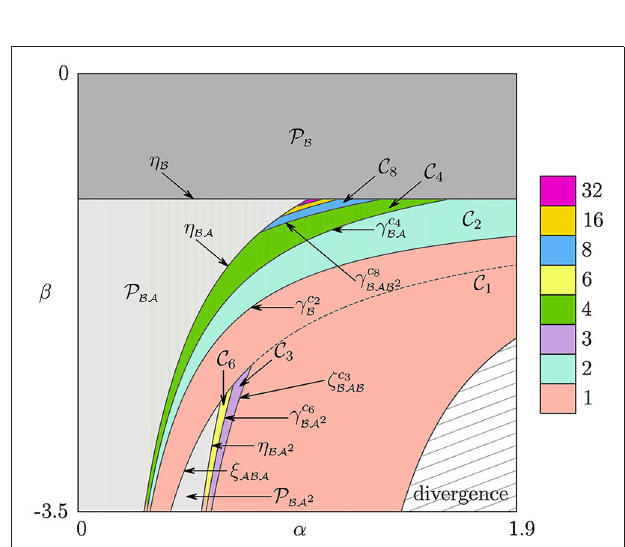
FIGURE 3 | Bifurcation structure of ( α , β ) parameter plane of the skew tent map.